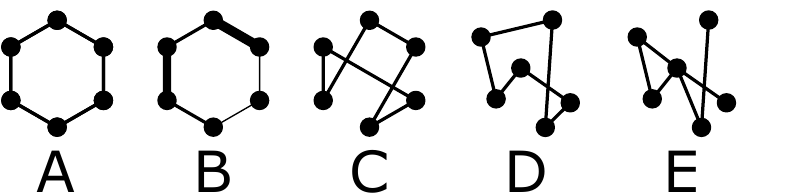
Figure 2. Schematic representation of the system labels. ( A ): regular lattice, ( B ): regular lattice with polydispersity, ( C ): regular structure with random topology, ( D ): random structure and topology, ( E ): random structure and non-uniform